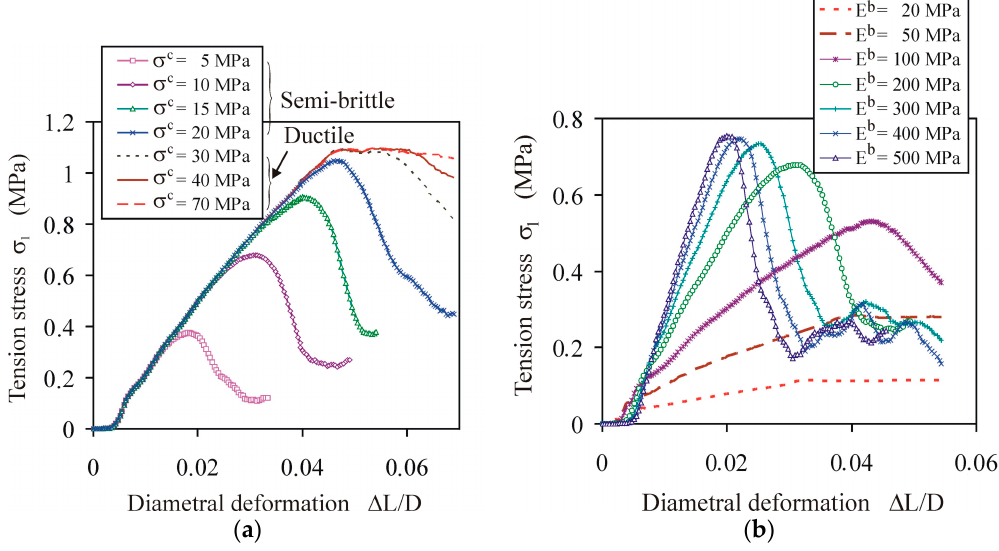
Figure 6. Tension stress vs. diametral deformation relationships σ 1 ( Δ L / D ): ( a ) effect of the bond strength σ c = τ c for E b = 200 MPa; ( b ) effect of the bond’s Young’s modulus for σ c = τ c = 10 MPa.